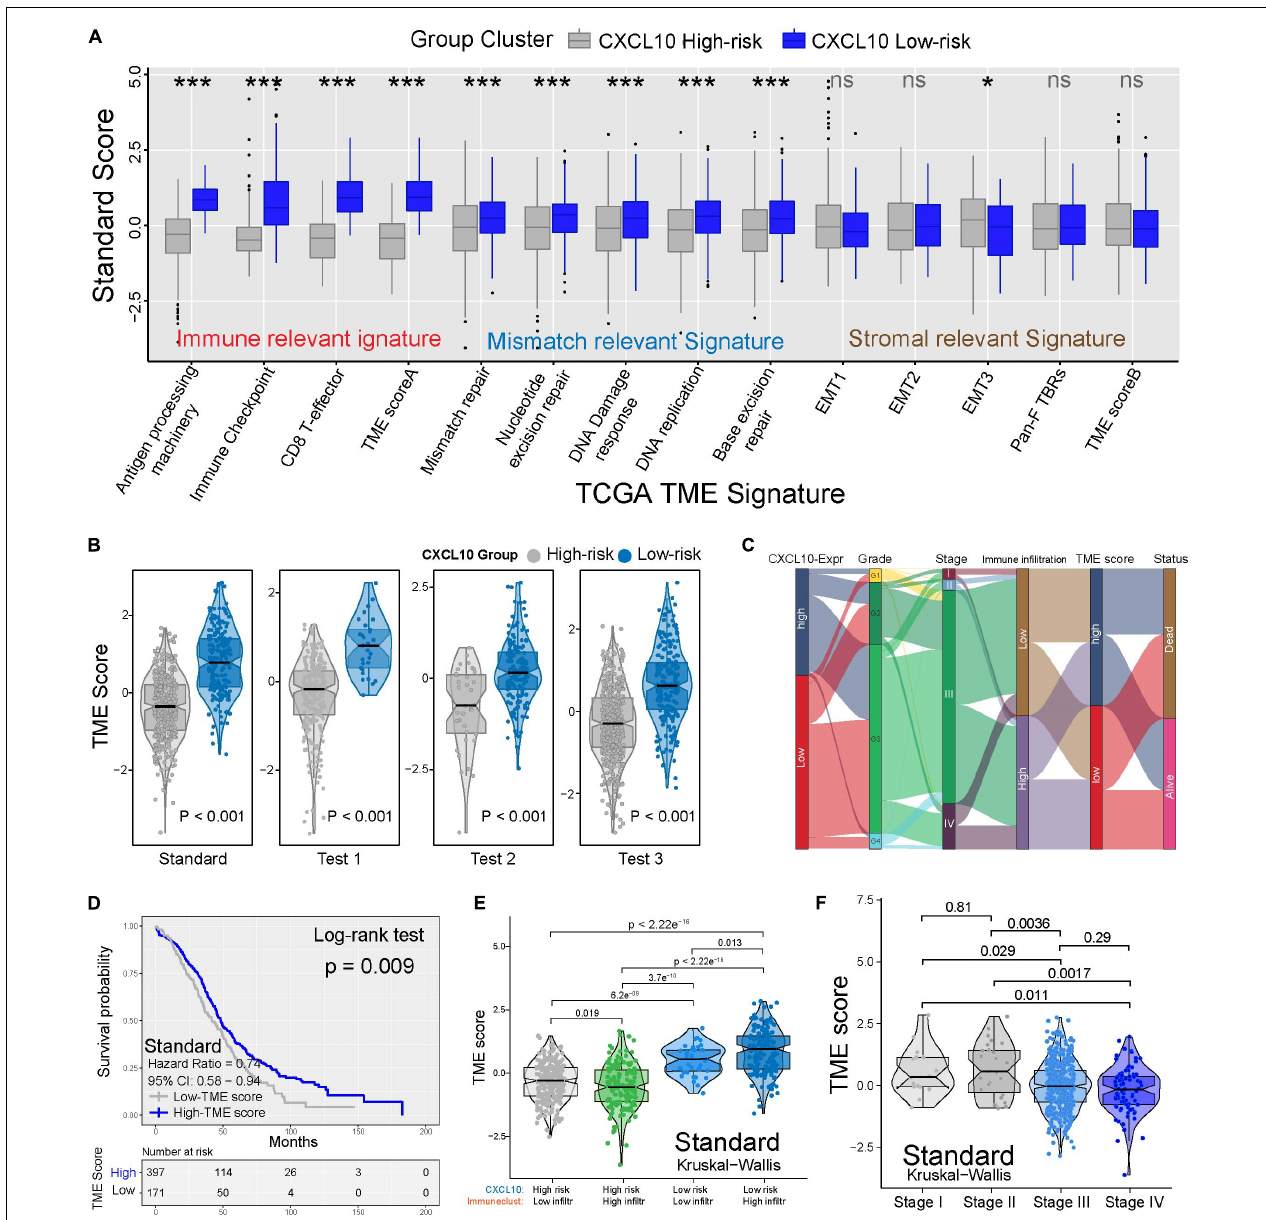
FIGURE 5 | TME characteristics with risk classification and tumor development. (A) TME different signatures (immune-relevant signature, mismatch-relevant signature and stromal-relevant signature) score between high- and low-risk classification. The lines in the boxes represented median value. The asterisks represented the statistical P value (* P < 0.05; ** P < 0.01; *** P < 0.001). (B) Differences of TME score in high- and low-risk classification from four independent cohorts. (C) Sankey diagram showed the link of high- and low-risk classifications, grades, stages, immune cell infiltration, TME scores, and survival outcomes. (D) Kaplan-Meier curves indicated that higher TME score was significantly associated with better OS in standard cohort ( P = 0.009, Log-rank test). (E) Differences in TME scores were positively associated with CXCL10-related immune cell infiltration. Patients with different TME score were stratified by both CXCL10 risk classification (high/low) and TME infiltration cluster (high/low). The Kruskal-Wallis test was applied to compare the differences between every two groups ( p < 0.0001). (F) Differences in TME scores among different pathological stages of ovarian cancer. The thick line represented the median value. The differences between every two groups were analyzed by Kruskal-Wallis test. ( p <